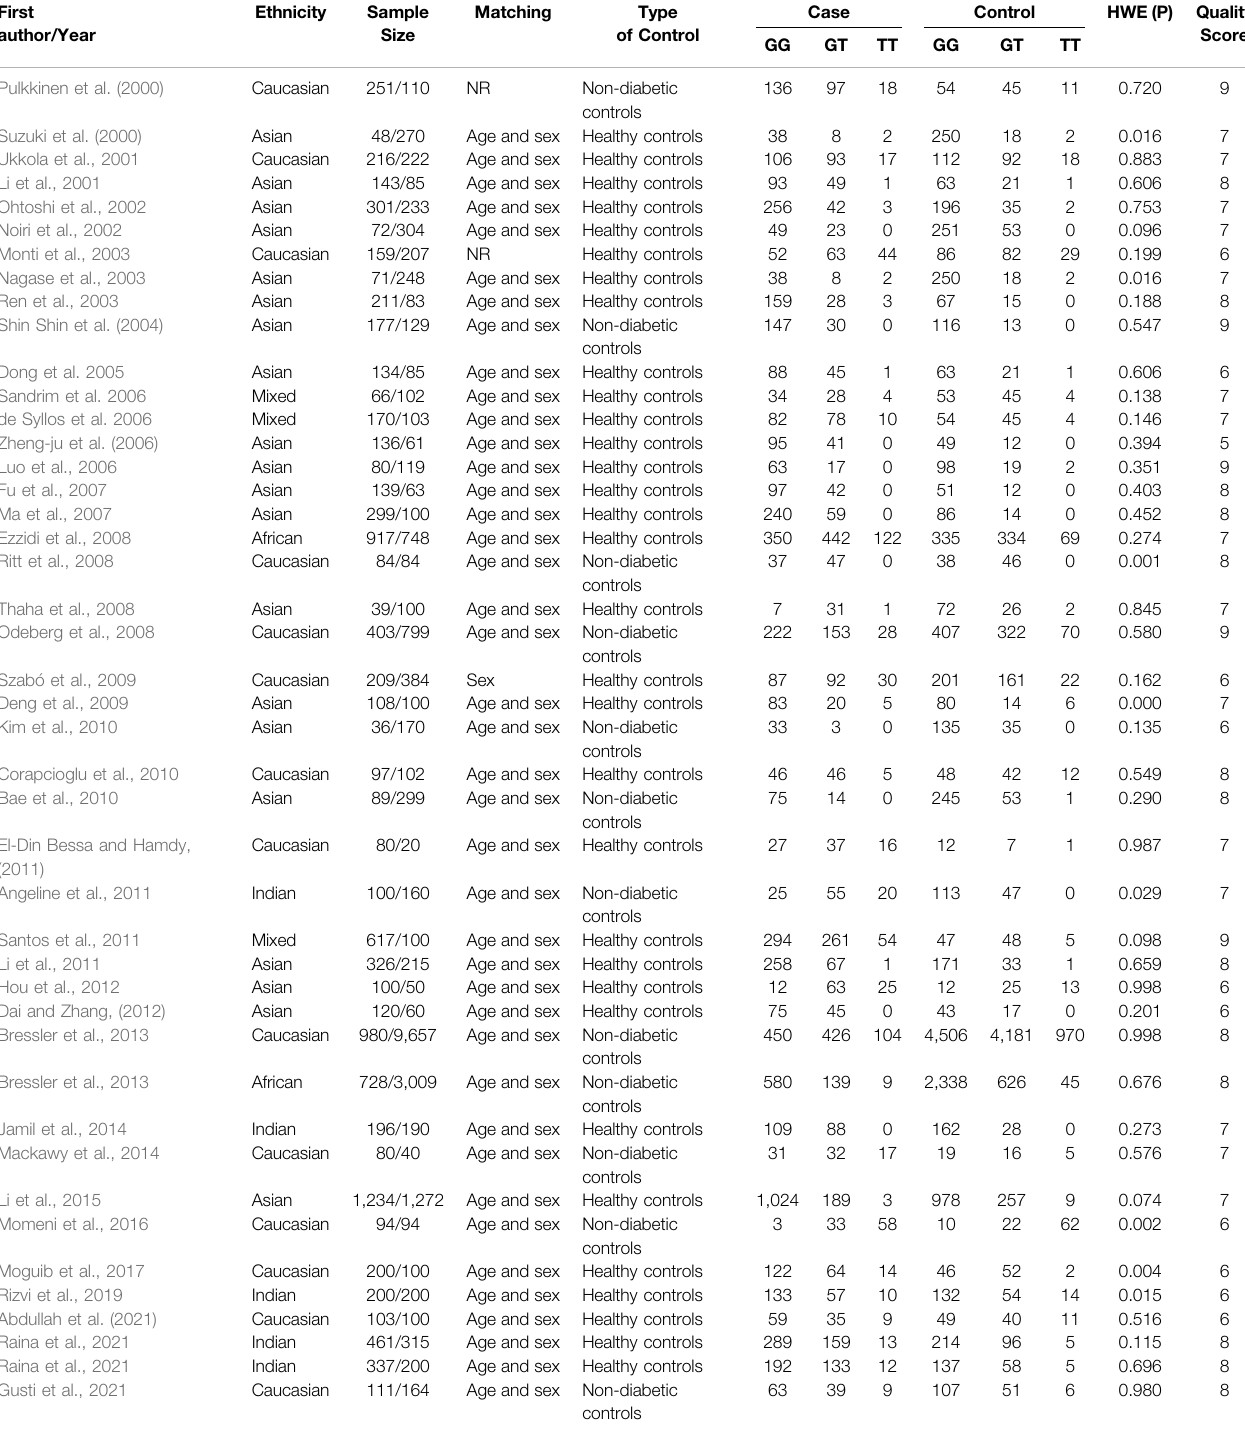
TABLE 3 | Genotype distribution of eNOS G894T polymorphisms in the included studies of